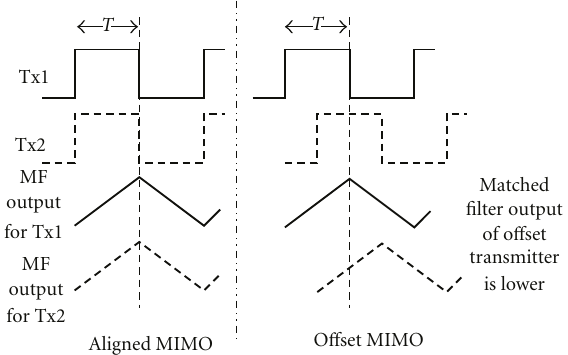
Figure 1: Reduction of interference power in o ff set